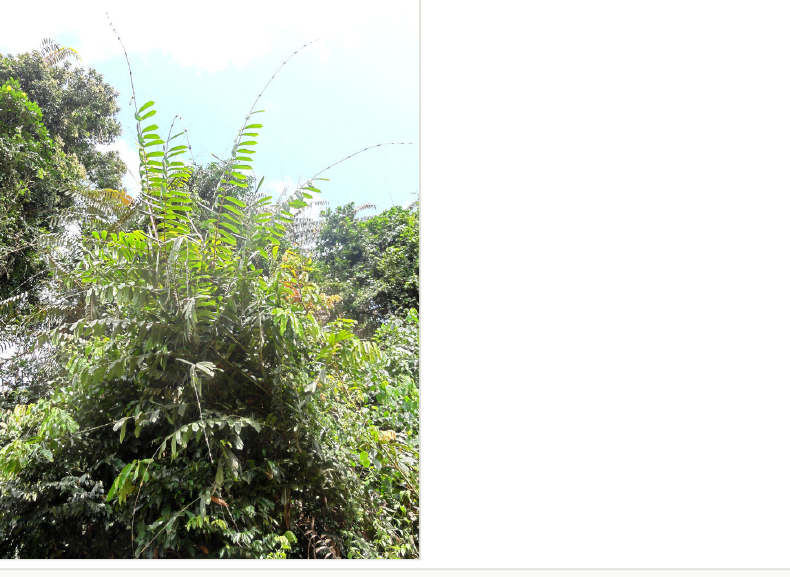
Figure 1. Eremospatha drans fi eldii in the "Forêt Classée de N'zodji", Côte d'Ivoire [Photo Credit: Doudjo Ouattara, 2016]